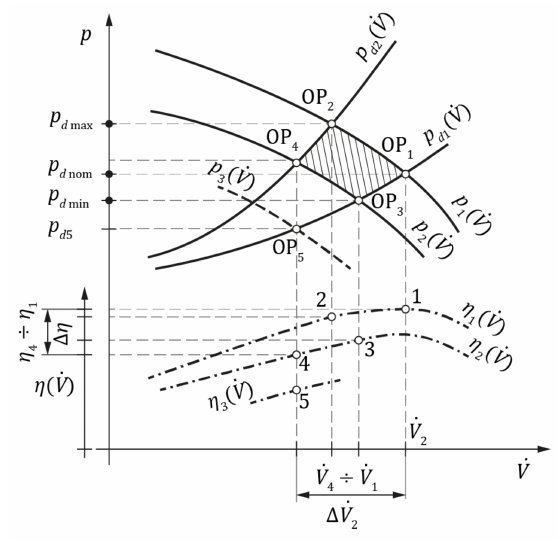
Figure 3. E ff ects of wear. Index: 1—nominal wear margin; 2—exhausted wear